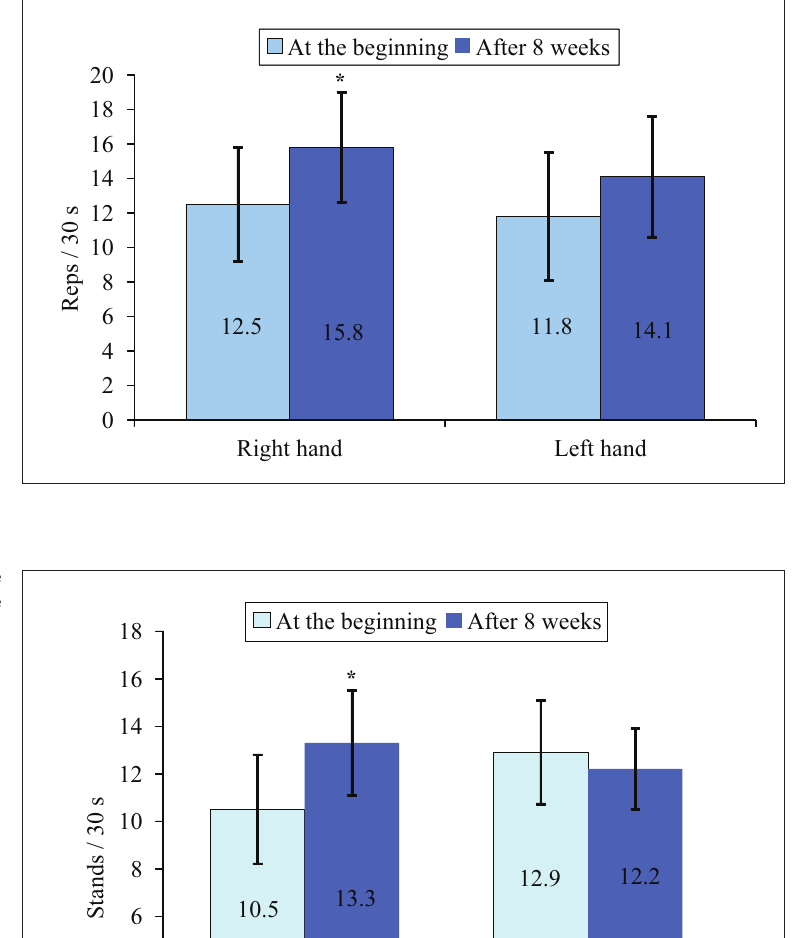
Figure 3. 30 s arm curl test results in the experimental group at the beginning and after an 8- week strength training program